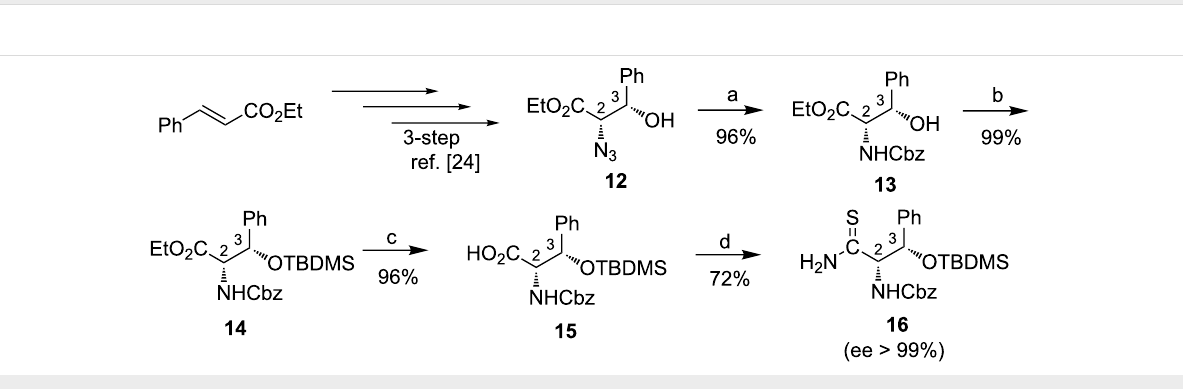
Scheme 2: Synthesis of chiral thioamide 16 . Reaction conditions: a) SnCl 2 ∙ 2H 2 O, dioxane/H 2 O (1:3), 0 °C to rt, 5 h, then NaHCO 3 , benzyl chloro- formate, rt, 18 h, 96%. b) TBDMSCl, imidazole, DMF, rt, 16 h, 99%. c) LiOH ∙ H 2 O, DME/H 2 O (1:1), 0 °C to rt, 72 h, then HCl, 96%. d) DCC, HOSu, THF, rt, 16 h, then Lawesson’s reagent, DME, rt, 36 h,